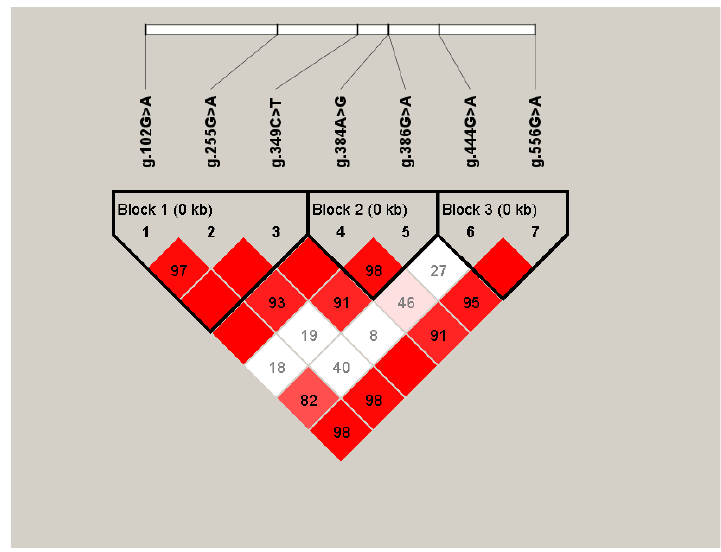
Figure 2. Linkage disequilibrium analysis of SNPs of G0S2 gene. Table 5. Haplotype composition of the three linkage regions.